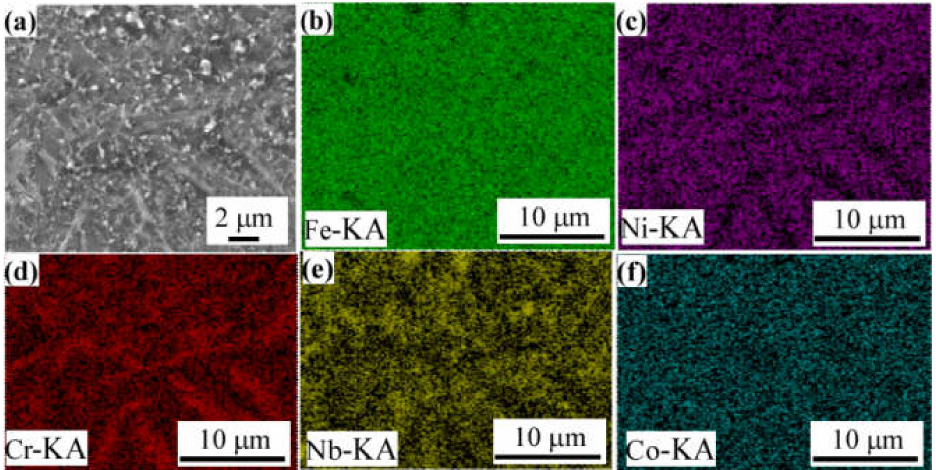
Figure 5. Elemental distribution of the FeCoNiCrBSiNb coating. ( a ) cross-sectional morphology;